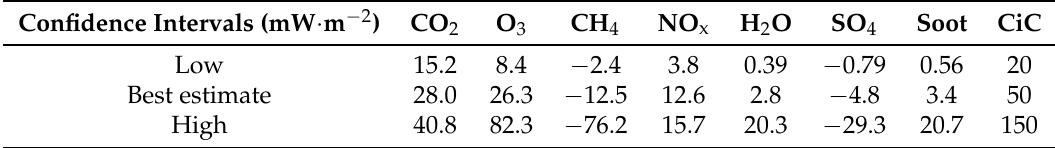
Table 1. Radiative forcing (RF) components from aviation effects in 2005 and 2010 (contrail-induced cloudiness (CiC)). Values and confidence intervals are taken from Lee et al. [1] and IPCC (Intergovernmental Panel of Climate Change)